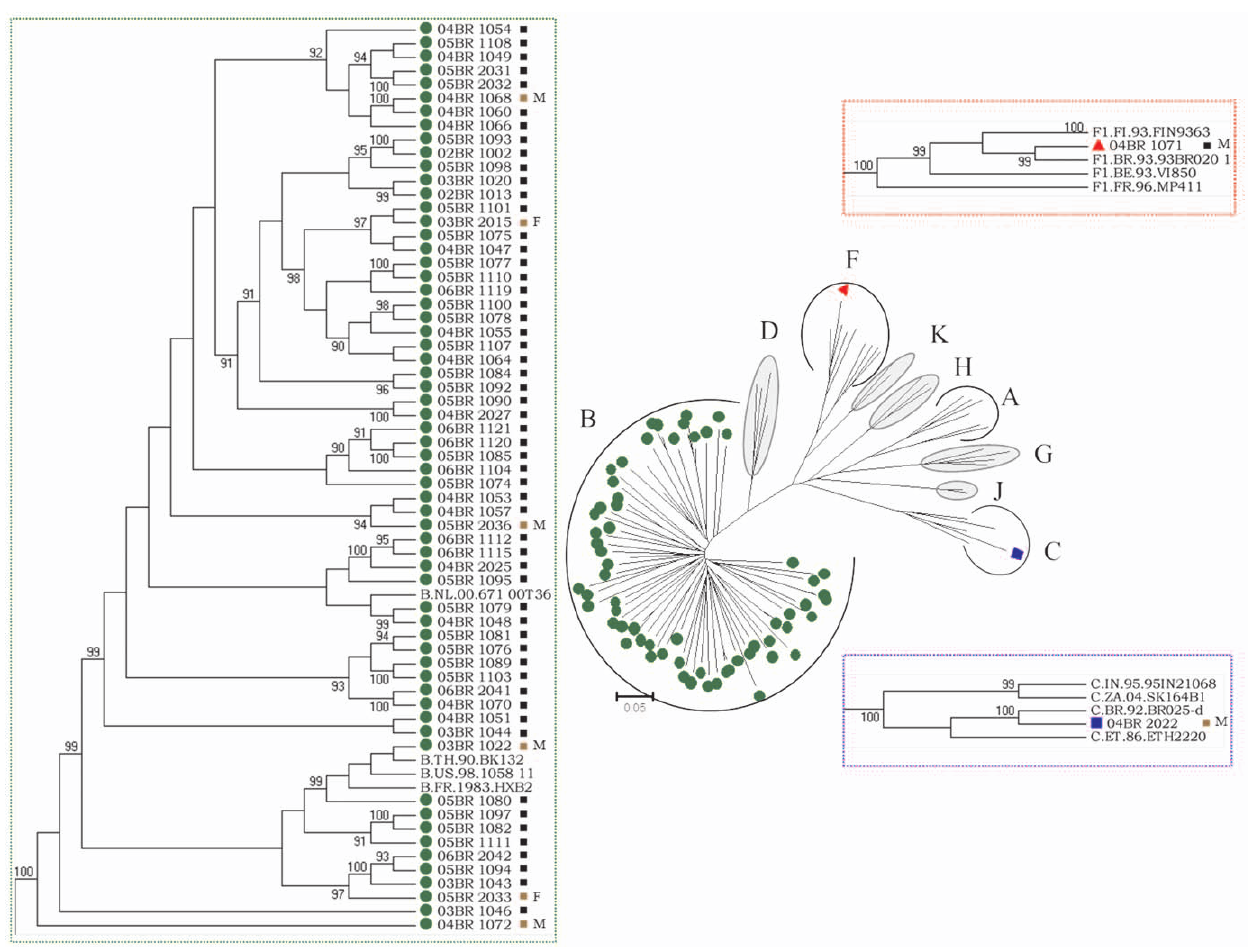
Figure 1. Phylogenetic tree constructed using a maximum-likelihood method from the NFLG sequences of 64 patient samples and 37 HIV-1 reference sequences from the Los Alamos HIV-1 database representing 11 genetic subtypes. Annotation of samples is as follows: symbol-green circle (subtype B), symbol-blue square (subtype C), symbol-red triangle (subclade F1), symbol-brown square-M indicates heterosexual male, symbol-brown square-F indicates heterosexual female, and symbol-black square indicates homosexual male. The approximate likelihood ratio test (aLRT) values of $ 90% are indicated. The scale bar represents 0.05 nucleotide substitutions per site.